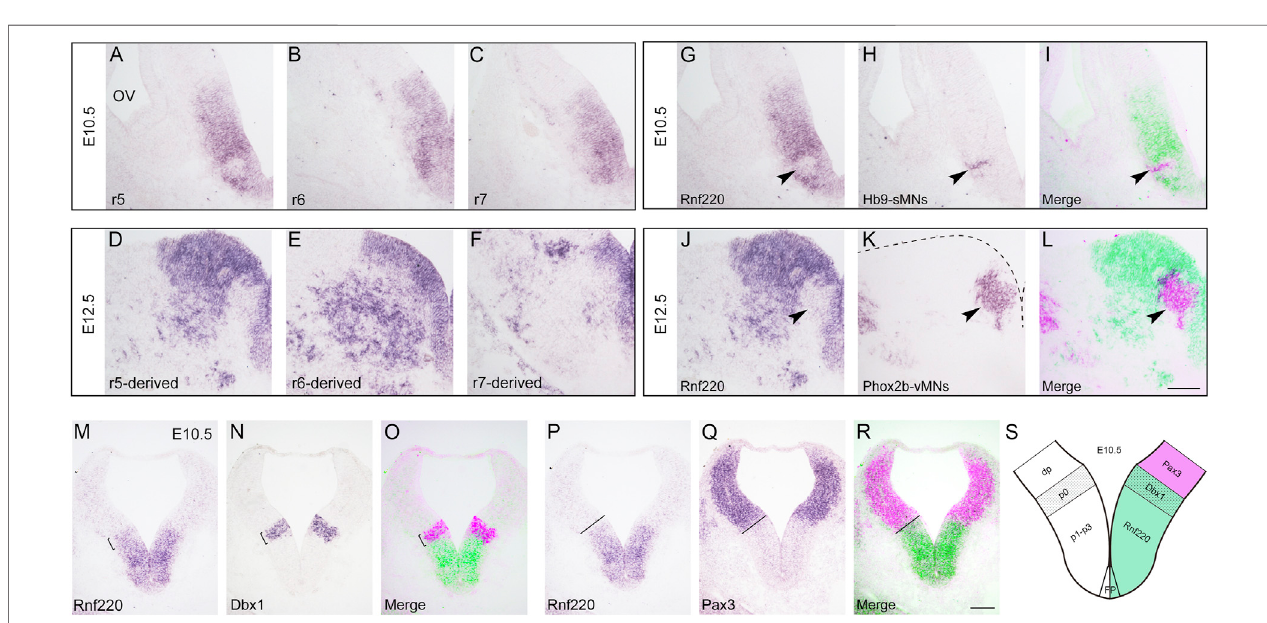
FIGURE 1| Expression of Rnf220 in the Developing Hindbrain. (A – C) In situ hybridization for Rnf220 of wild-type embryos at E10.5. Rnf220 isexpressed in the VZ oftheventralneuraltubeandafewpost-mitoticcellsinthemantlezone.OV,oticvesicle;r5-r7,sectionatrhombomere5-7levels. (D – F) Insitu hybridizationfor Rnf220 of wild-typeembryosatE12.5. Rnf220 isexpressedintheVZoftheventralneuraltubeandmanypost-mitoticcellsoutsidetheVZ. (G – I) Insitu hybridizationfor Rnf220 and Hb9 onadjacentsections atther5levelofwild-typeembryosatE10.5. Rnf220 (green)and Hb9 (magenta)areshownbypseudocolor (I) .Feworveryweak Rnf220 expression is present in Hb9 + sMNs (arrowheads). sMNs, somatic motor neurons. (J – L) In situ hybridization for Rnf220 and Phox2b on adjacent sections at the r5- derived level of wild-type embryos at E12.5. Rnf220 (green) and Phox2b (magenta) are shown by pseudocolor (L) . Rnf220 is not expressed in Phox2b + vMNs (arrowheads). Dashed line in (K) shows the boundary of the hindbrain. vMNs, visceral motor neurons. Scale bar, 100 μ m (L) ; also applies to A – K) . (M – O) In situ hybridization for Rnf220 and Dbx1 (a p0 domain marker) on adjacentslidesof E10.5 wild-type embryos. Dbx1 (magenta) and Rnf220 (green) are shown bypseudocolor (O) . The uppermost territory of Rnf220 expression domain corresponds well with that of Dbx1 (brackets). (P – R) In situ hybridization for Rnf220 and Pax3 (a dp1-dp6 domain marker) onadjacent slidesofE10.5wild-type embryos.The expression domain of Rnf220 isadjacent tothatof Pax3 (dashedlines). Pax3 (magenta) and Rnf220 (green) are shown by pseudocolor (R). Scale bar, 100 μ m (R) ; also applies to (M – Q) . (S) Diagram showing the expression pattern of Rnf220 in the E10.5 hindbrain. Rnf220 is expressed from p0 to p3 domain and in the fl oor plate (FP) , fl oor plate.